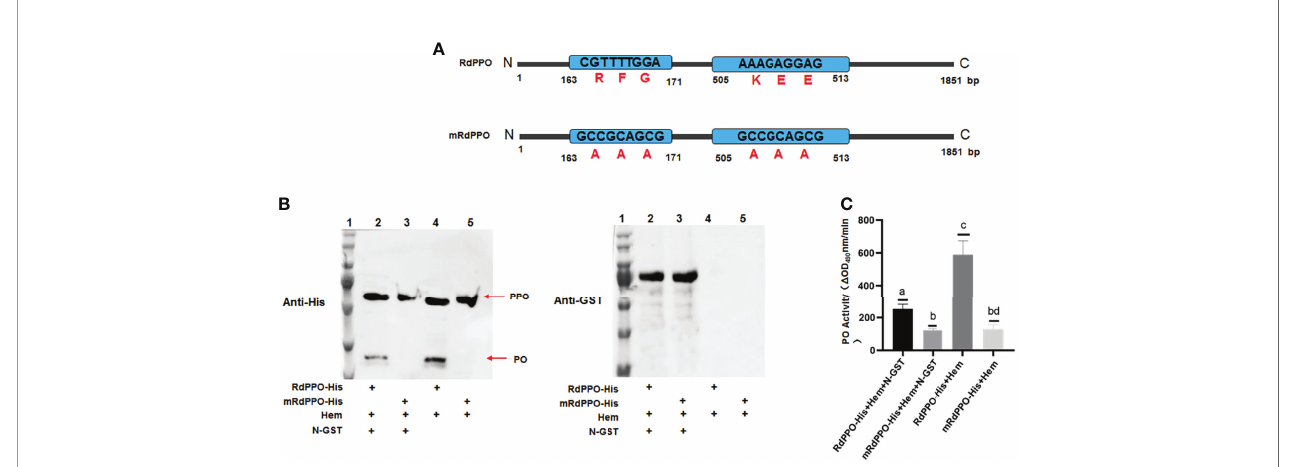
FIGURE 5 | RSMV N suppresses in vitro cleavage of RdPPOs into active RdPO. (A) Diagrams of RdPPO protein and RdPPO mutant protein (mRdPPO). The amino acids in the cleavage sites of mRdPPO were substituted with alanine, (A, B) Puri fi ed RdPPO-His (20 ng, 10 m L) or mRdPPO-His (20 m g, 10 m L), N-GST (20 ng, 10 m L), and hemolymph samples (Hem, 20 m L) were incubated at 30°C for 1 (h) The reaction mixture and controls without N-GST were separated by 10% SDS/PAGE and examined by immunoblotting with 6×His antibody (left) or GST antibody (right) (lane 1, position of the protein marker; lane 2, mixture of RdPPO-His/N-GST/Hem; lane 3, mixture of RdmPPO-His/N-GST/Hem; lane 4, mixture of PPO-His/Hem; lane 5, mixture of RdmPPO -His/Hem. The PPO precursor and PO are marked with arrows. (C) PO activity of the samples in (A) . Mixtures were collected at 1 h post incubation and subjected to PO activity assays. Each value is given as the mean ±